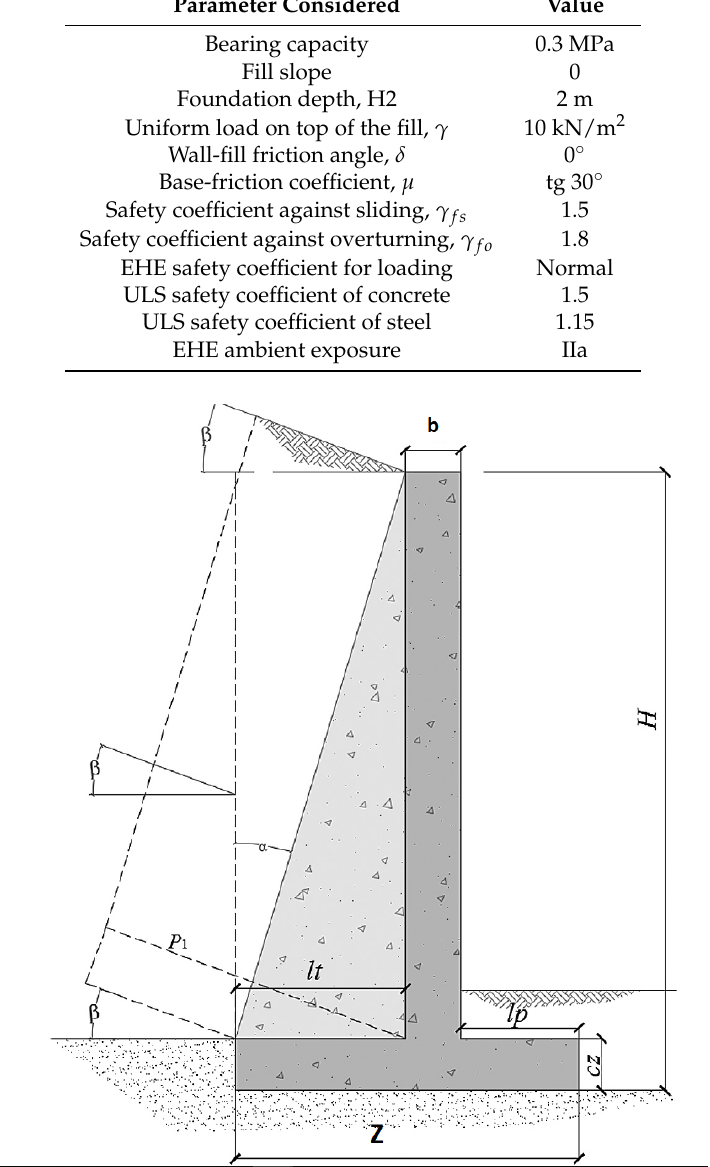
Figure 4. Problem design parameters. Source: